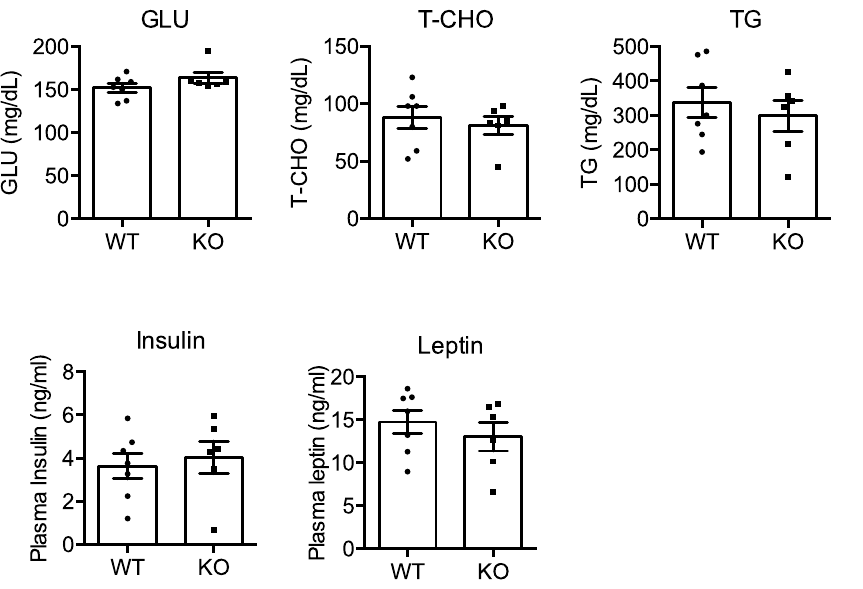
Figure 6. Blood biochemistry of male WT and NMU KO rats fed a high fat diet. Serum levels of GLU, T-CHO, and TGs were measured by an automatic biochemistry analyzer. Plasma levels of insulin and leptin were measured by ELISAs. All data represent means ± SEM (n = 6).